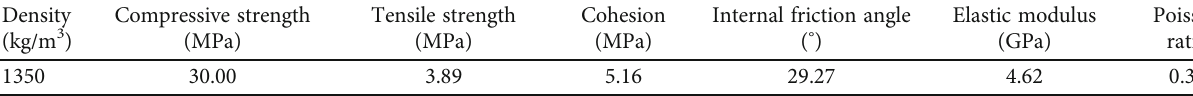
Table 1: Average physical and mechanical parameters of the coals.